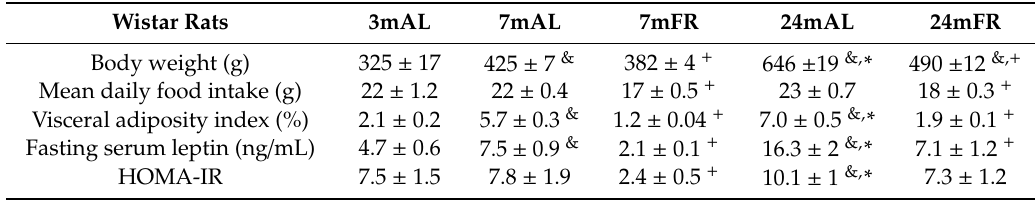
Table 1. General characteristics of the ageing model.